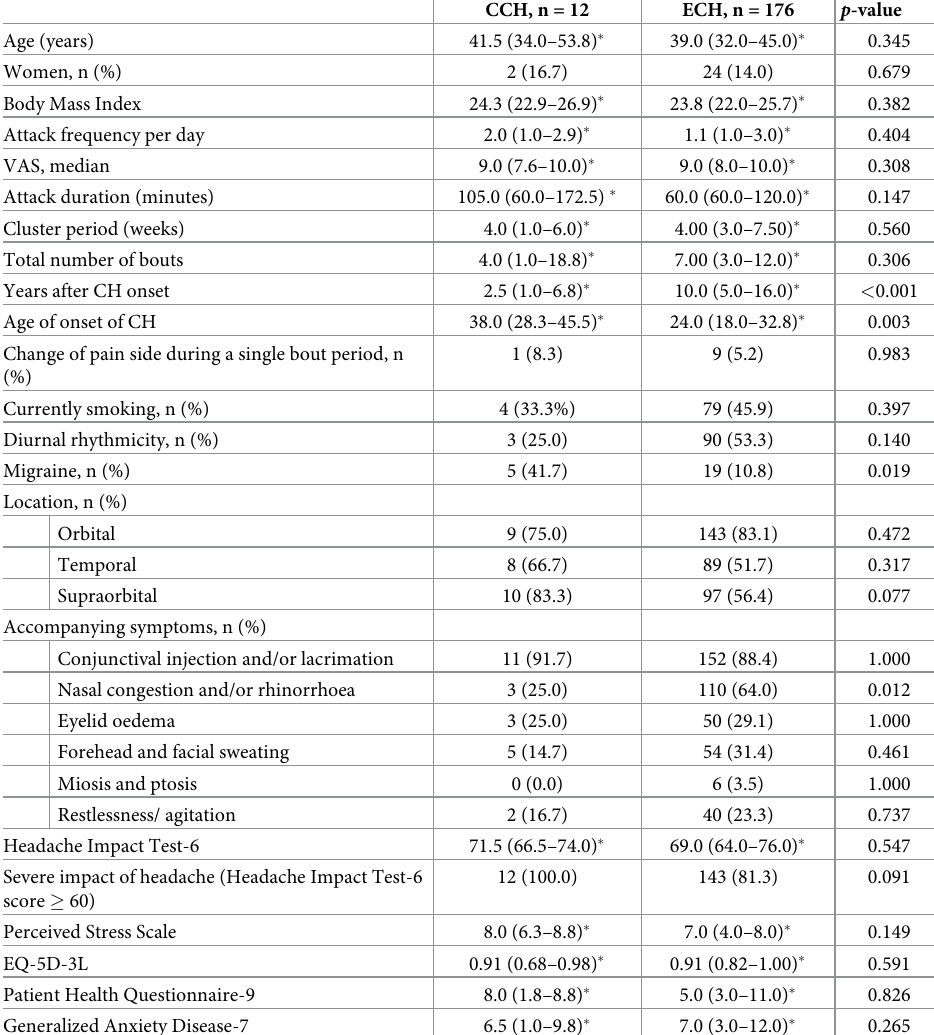
Table 1. Clinical features of participants with chronic cluster headache and episodic cluster